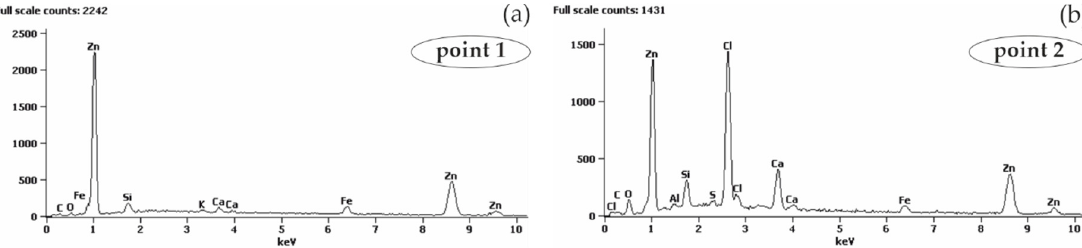
Figure 19. Spectra obtained from energy-dispersive X-ray spectroscopy (EDS) method for areas marked in Figure 18b: ( a ) from point 1 ( b ) from point 2